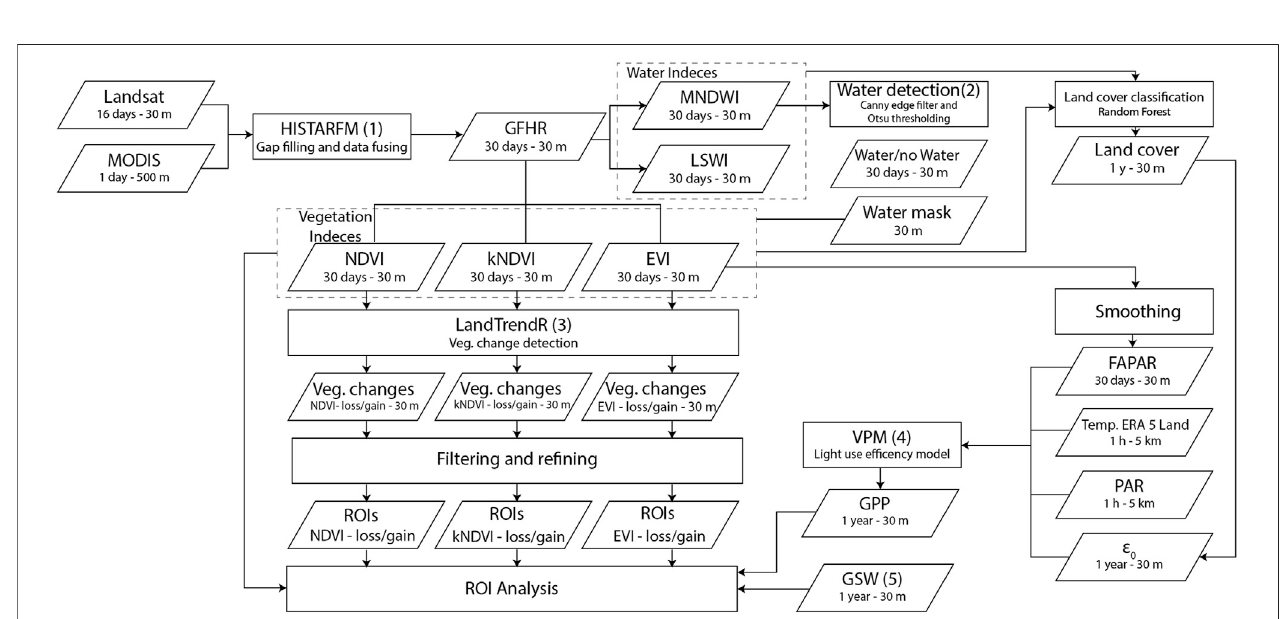
FIGURE 3 | Flowchart of the framework used for the vegetation analysis. (1) Moreno-Martínez et al. (2020), (2) Donchyts et al. (2016) (3) Robinson et al. (2017), (4) Xiao et al. (2005), (5) Pekel et al. (2016).